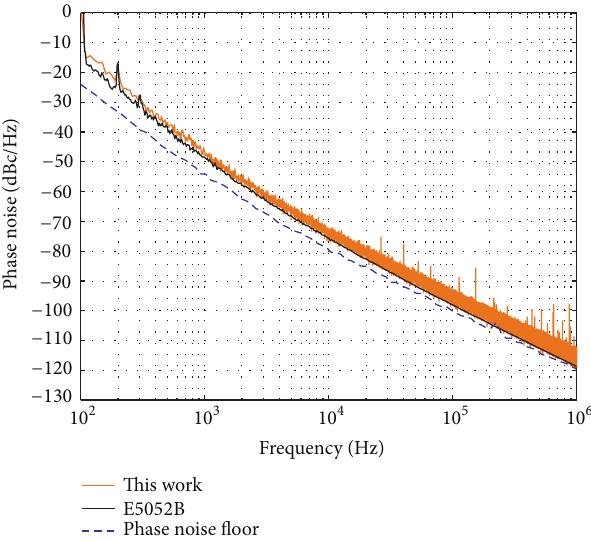
Figure 13: Phase noise measurements of a VCO from HITTITE- HMC587LC4B ( 𝑃 𝑖𝑛 = −6.6 dBm).